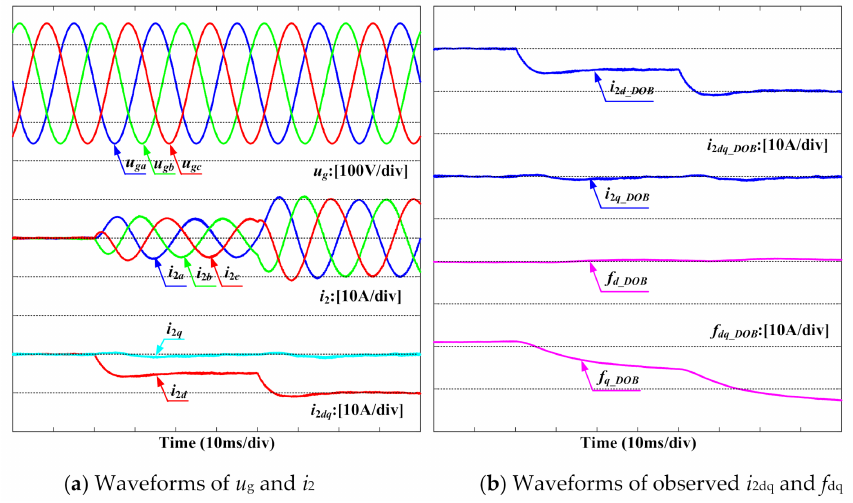
Figure 12. Simulation waveforms for nominal charging